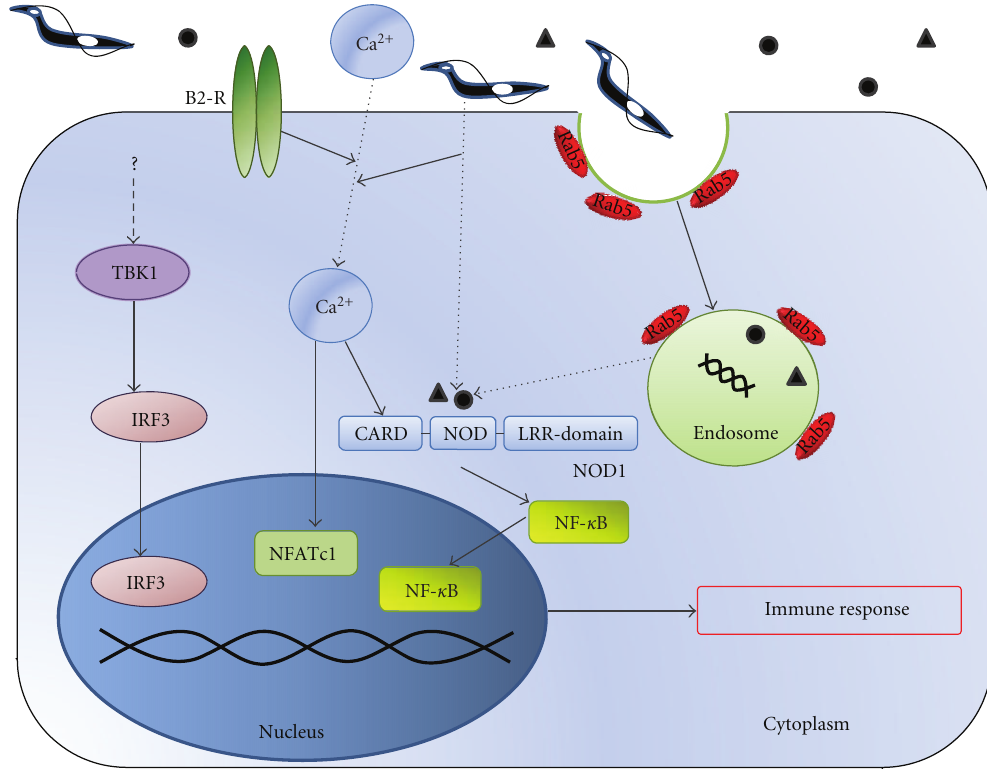
Figure 2: TLR-independent innate immune responses. Infection triggers increased intracellular Ca 2+ concentration through interaction of bradykinin with the bradykinin B2 receptor (B2-R) among other mechanisms. Target innate immune cells utilize Ca 2+ to activate the Ca- dependent signaling pathway leading to the activation of NFATc1. Intracellular T. cruzi is recognized by NOD1, activating NF- κ B. T. cruzi is also recognized by unknown molecules leading to the activation of TBK1 and IRF3. Altogether the mechanisms participate in the induction of an e ff ective immune response against the